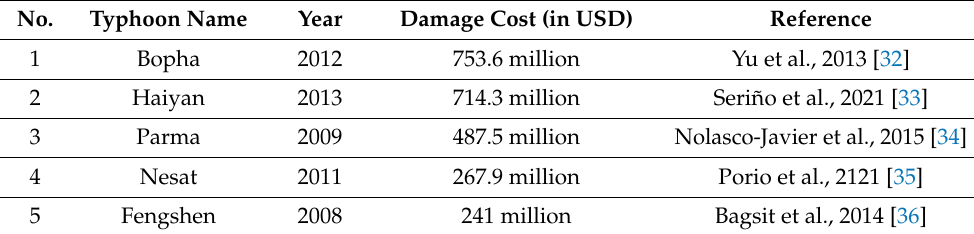
Table 1. Summary of the costliest typhoon events in the